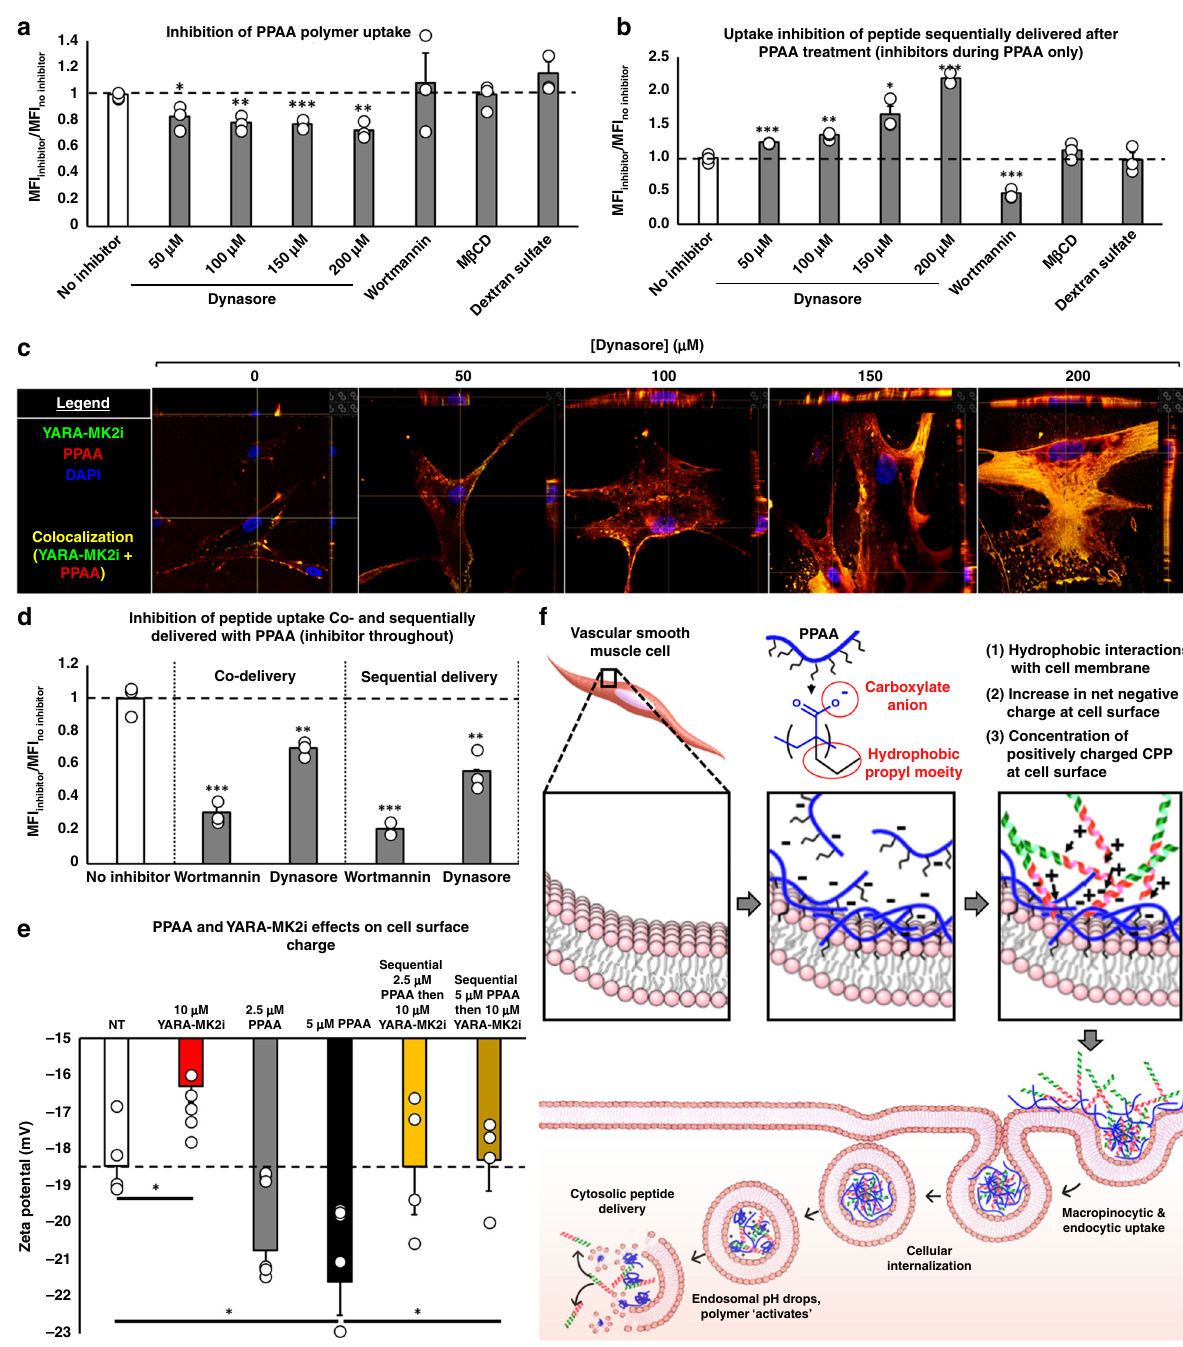
Fig. 3 Mechanism of action for PPAA-mediated CPP uptake. a Inhibition of rhodamine labeled PPAA polymer uptake in HCAVSMCs. b The effect of adding inhibitors during PPAA pretreatment on subsequent uptake of Alexa-488 labeled YARA-MK2i peptide in HCAVSMCs (inhibitors applied during PPAA treatment only). c Representative Z-stack images (images have x and y projections of 3-dimensional z-stack images below and to the right of each image, respectively) of the dose-dependent effects of dynasore during PPAA pretreatment on fl uorescently labeled polymer and peptide uptake. d The effects of adding inhibitors throughout the entire treatment for both co-delivery and sequential delivery of PPAA and Alexa-488 labeled YARA-MK2i peptide in HCAVSMCs. For a , b , d , * p < 0.05, ** p < 0.01, *** p < 0.001 vs. no inhibitor. e Zeta potential measurement of PPAA and YARA-MK2i peptide mediated changes in extracellular surface charge of HCAVSMCs, * p < 0.05. f Schematic representation of the proposed mechanism of action for PPAA-mediated CPP-peptide uptake and intracellular delivery. Poly(propylacrylic acid) (PPAA) interacts with the cell membrane via hydrophobic interactions with the propyl moiety of PPAA. This interaction increases the net negative charge of the cell membrane due to the carboxylate anion present on the polymer. This increase in net negative charge enhances cell surface electrostatic interactions with cationic CPPs, leading to enhanced peptide uptake through both macropinocytic and endocytic pathways. Following uptake, the decrease in endosomal pH results in protonation of the PPAA polymer. This pH change triggers the polymer to dissociate from the CPP-peptide cargo and interact with and destabilize the endosomal membrane, resulting in cytosolic peptide delivery. Statistical analyses were performed with a one-way ANOVA followed by Tukey ’ s post hoc test. Data are presented as means ± SEM